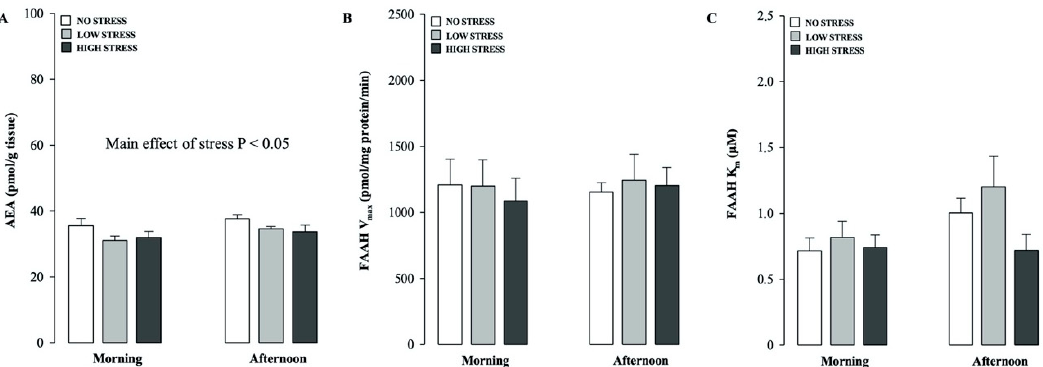
Figure 2. Time-of-day-dependent e ff ects of stress on short-term recognition memory influence hippocampal AEA levels and its degradation. Hippocampal AEA levels ( A ), and FAAH V max ( B ) and K m ( C ) values, as assessed immediately after the testing trial in non-cannulated rats that were subjected to no, low or high stress conditions after the training trial performed in the morning or afternoon. p < 0.05 main e ff ect of stress on hippocampal AEA levels. Data are expressed as mean ± SEM ( n = 7–8 per